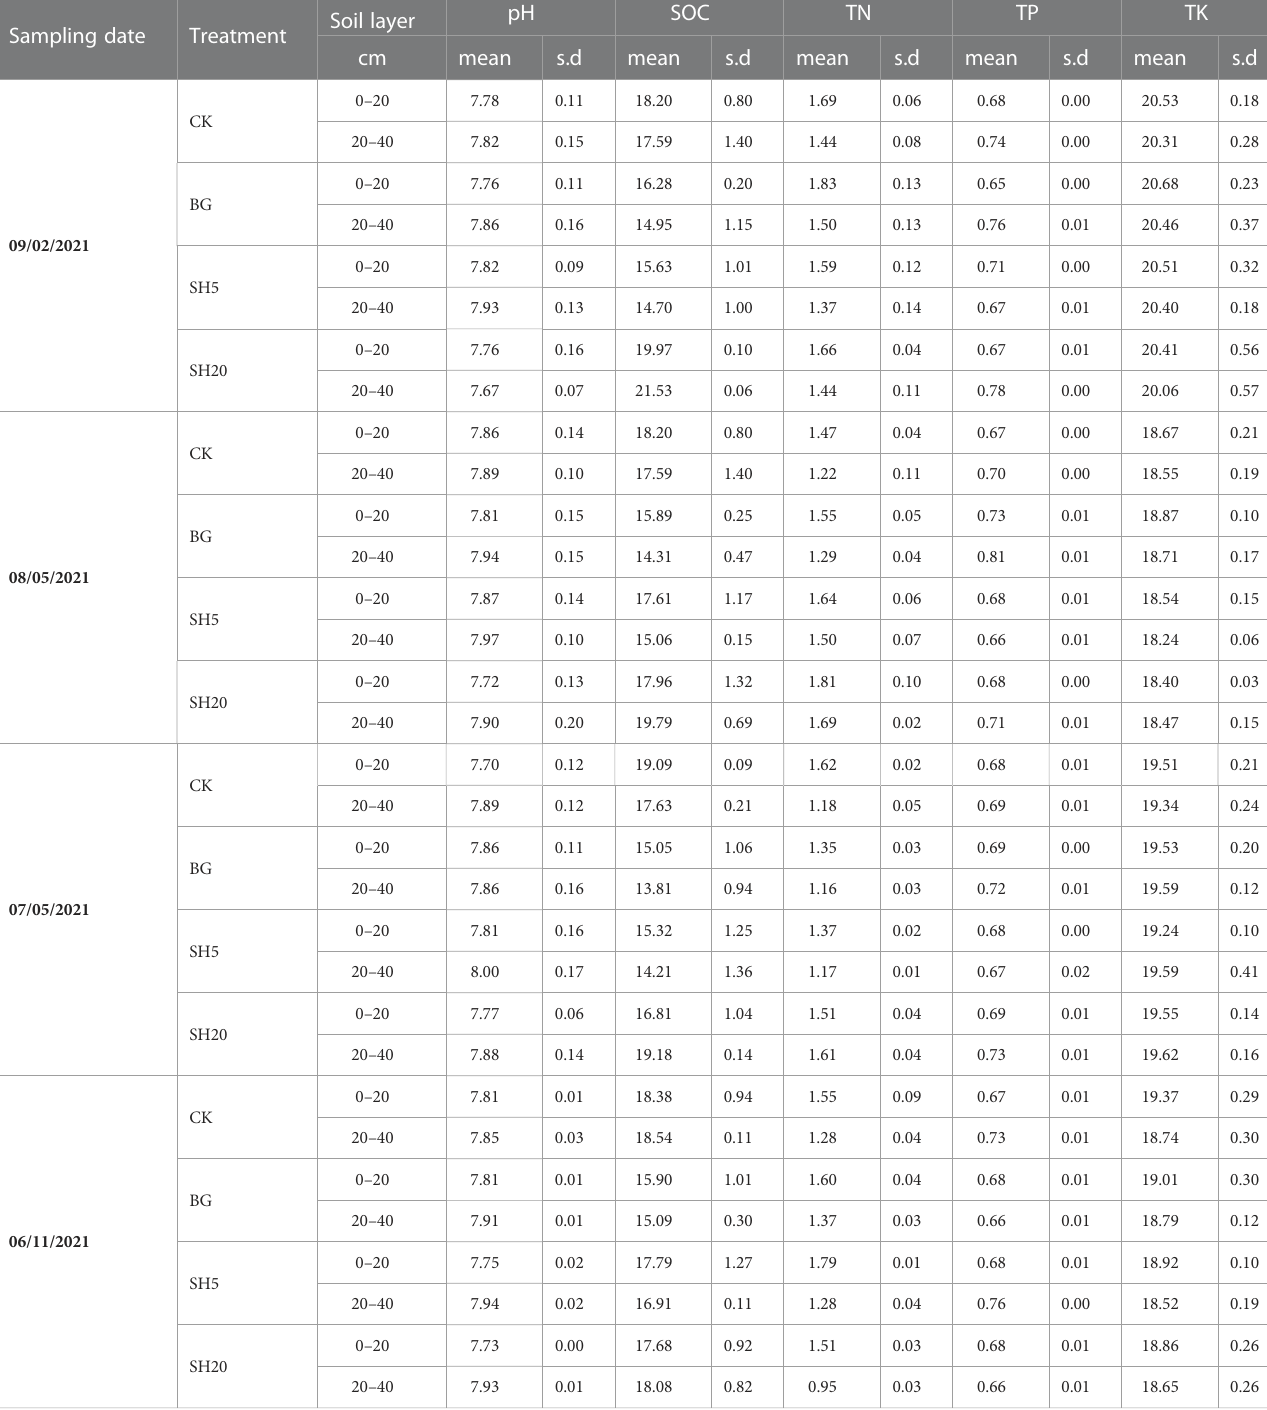
TABLE 1 Selected properties (pH, total concentration of soil organic carbon [SOC], N, P, and K) of soil under four treatments.